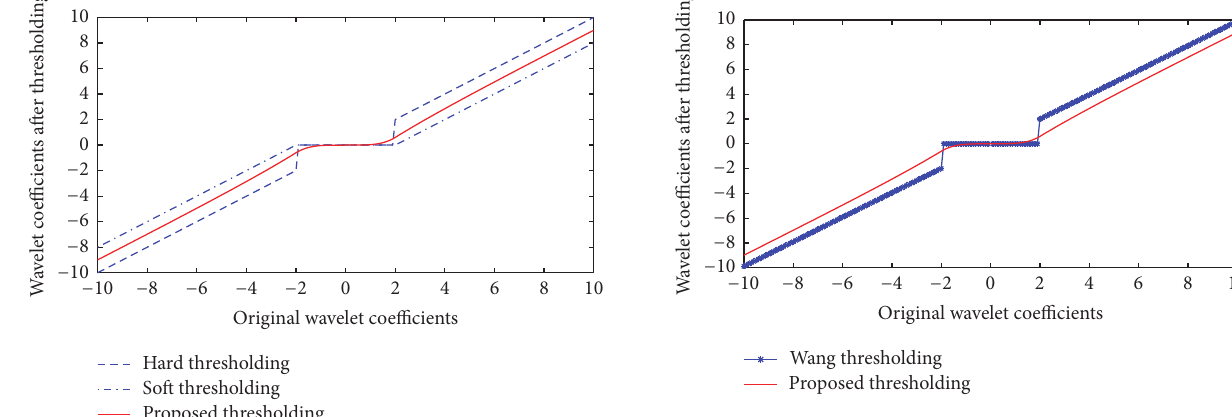
Figure 4: Comparison with Wang’s thresholding